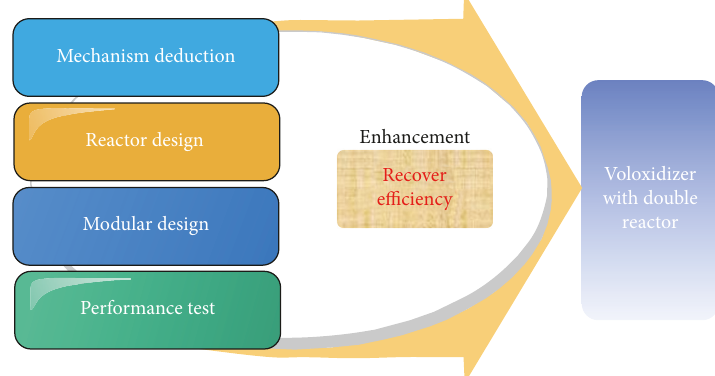
Figure 2: Double-reactor voloxidizer optimization stages/considerations.